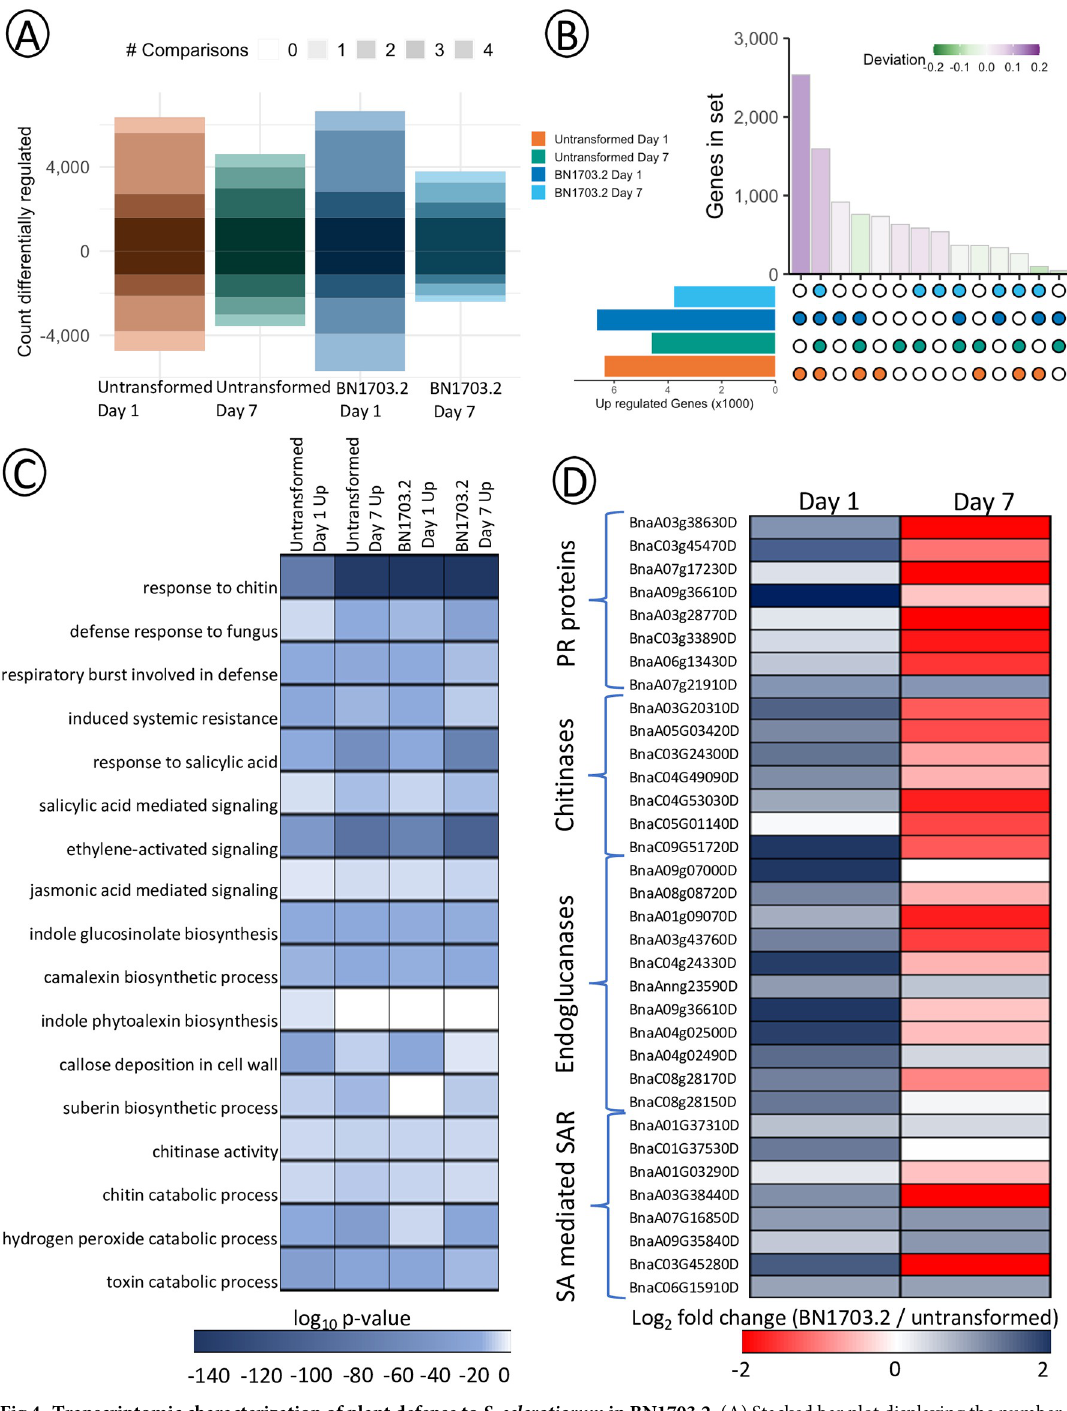
PLOS ONE | https://doi.org/10.1371/journal.pone.0261102 August 26,